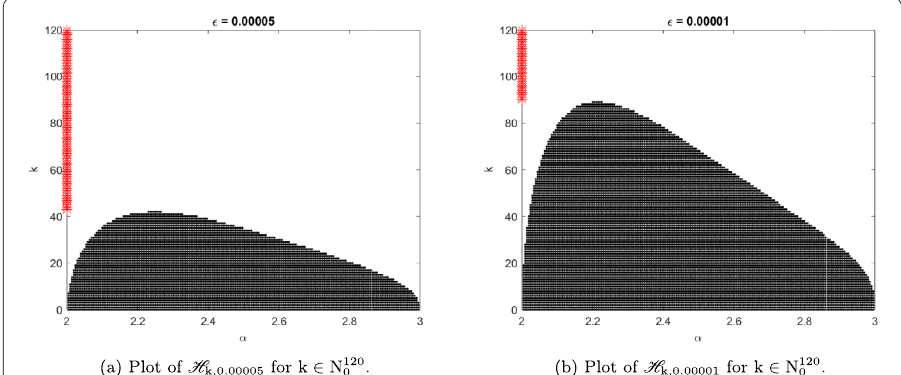
Figure 1 Plot of H k , (cid:4) for k ∈ N 120 0 and different values of